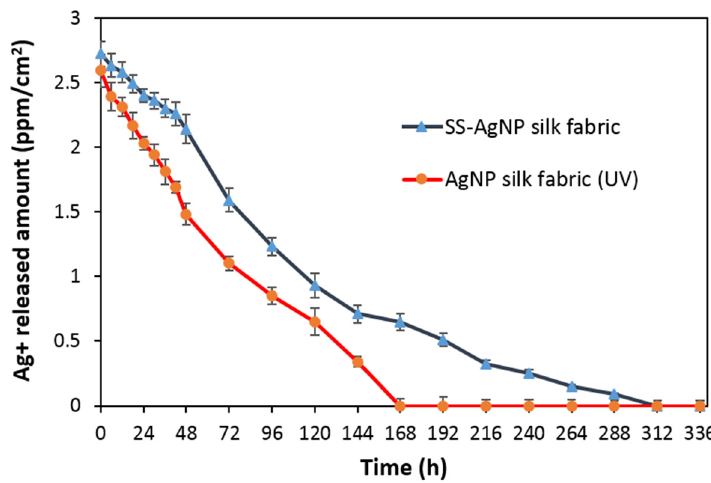
Figure 8. Ag + release profile of SS ‐ AgNP and AgNP finished silks. Table 6. Images of antibacterial activities against two bacterial types.